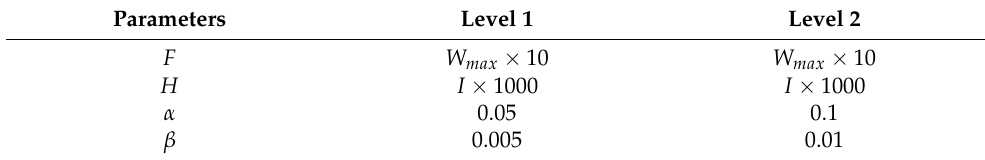
Table 4. The design factors for SA parameters.